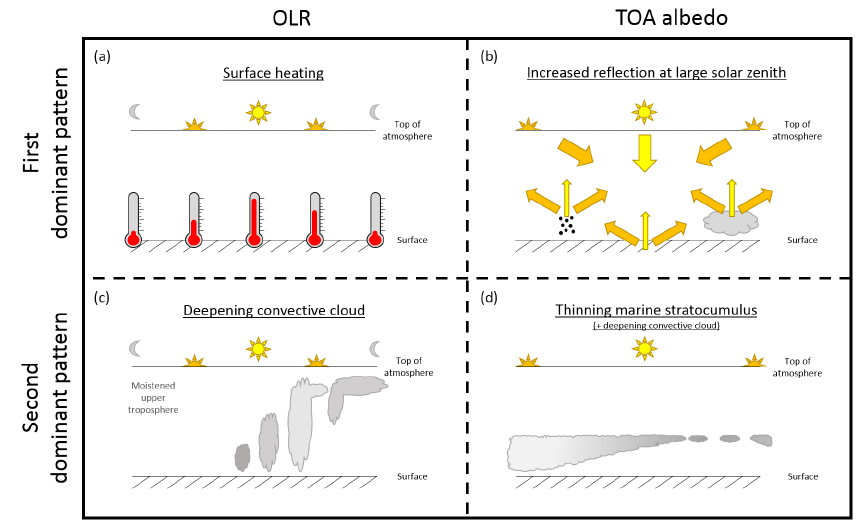
Figure 10. A schematic diagram showing the processes that control the first ( a and b ) and second ( c and d ) most dominant patterns in the diurnal variability of the outgoing long-wave radiation (OLR) ( a and c ) and top-of-atmosphere (TOA) albedo ( b and d ). Different arrow and Sun colours illustrate the change in solar zenith angle during the diurnal cycle and should not be interpreted as a change in wavelength. The separation of aerosol, surface and cloud reflection in the top right panel is for illustrative purposes only and does not relate to different parts of the diurnal